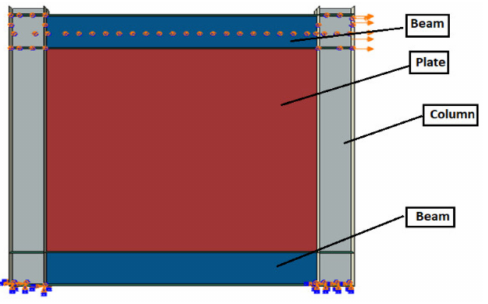
Figure 3. Finite element